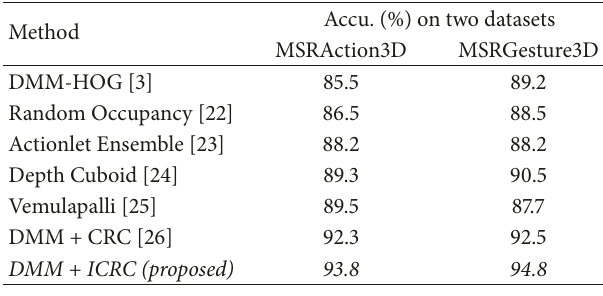
Table 1: Recognition accuracies (unit: %) comparison on the MSRAction3D dataset and MSRGesture3D dataset.